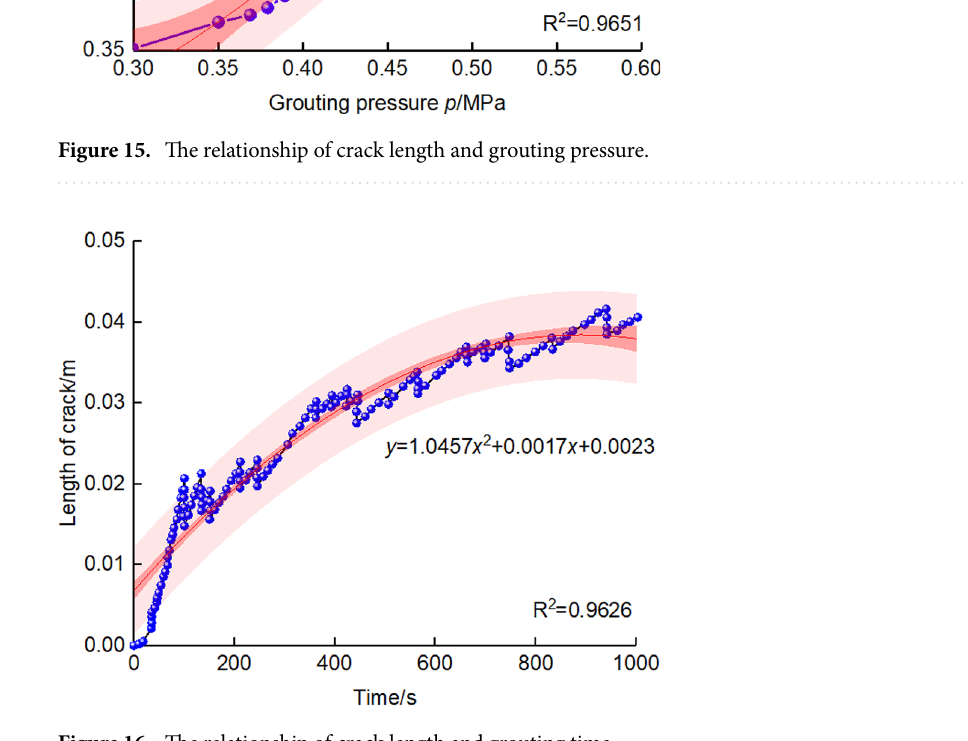
Figure 16. The relationship of crack length and grouting